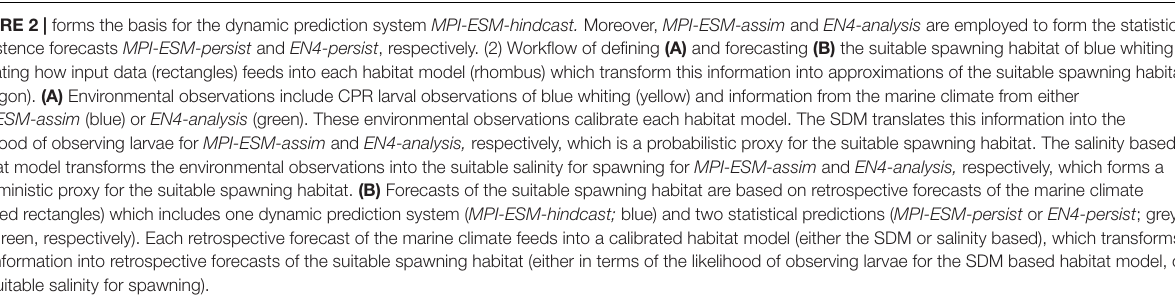
FIGURE 2 | forms the basis for the dynamic prediction system MPI-ESM-hindcast. Moreover, MPI-ESM-assim and EN4-analysis are employed to form the statistical persistence forecasts MPI-ESM-persist and EN4-persist , respectively. (2) Workflow of defining (A) and forecasting (B) the suitable spawning habitat of blue whiting, indicating how input data (rectangles) feeds into each habitat model (rhombus) which transform this information into approximations of the suitable spawning habitat (hexagon). (A) Environmental observations include CPR larval observations of blue whiting (yellow) and information from the marine climate from either MPI-ESM-assim (blue) or EN4-analysis (green). These environmental observations calibrate each habitat model. The SDM translates this information into the likelihood of observing larvae for MPI-ESM-assim and EN4-analysis, respectively, which is a probabilistic proxy for the suitable spawning habitat. The salinity based habitat model transforms the environmental observations into the suitable salinity for spawning for MPI-ESM-assim and EN4-analysis, respectively, which forms a deterministic proxy for the suitable spawning habitat. (B) Forecasts of the suitable spawning habitat are based on retrospective forecasts of the marine climate (dashed rectangles) which includes one dynamic prediction system ( MPI-ESM-hindcast; blue) and two statistical predictions ( MPI-ESM-persist or EN4-persist ; grey and green, respectively). Each retrospective forecast of the marine climate feeds into a calibrated habitat model (either the SDM or salinity based), which transforms this information into retrospective forecasts of the suitable spawning habitat (either in terms of the likelihood of observing larvae for the SDM based habitat model, or the suitable salinity for